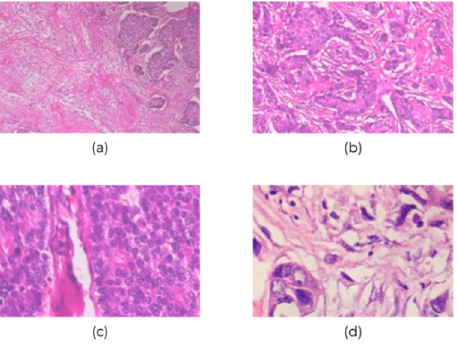
Figure 2. Sample images of breast cancer histopathological at ( a ) 40 × , ( b ) 100 × , ( c ) 200 × , and ( d ) 400 × magnification.